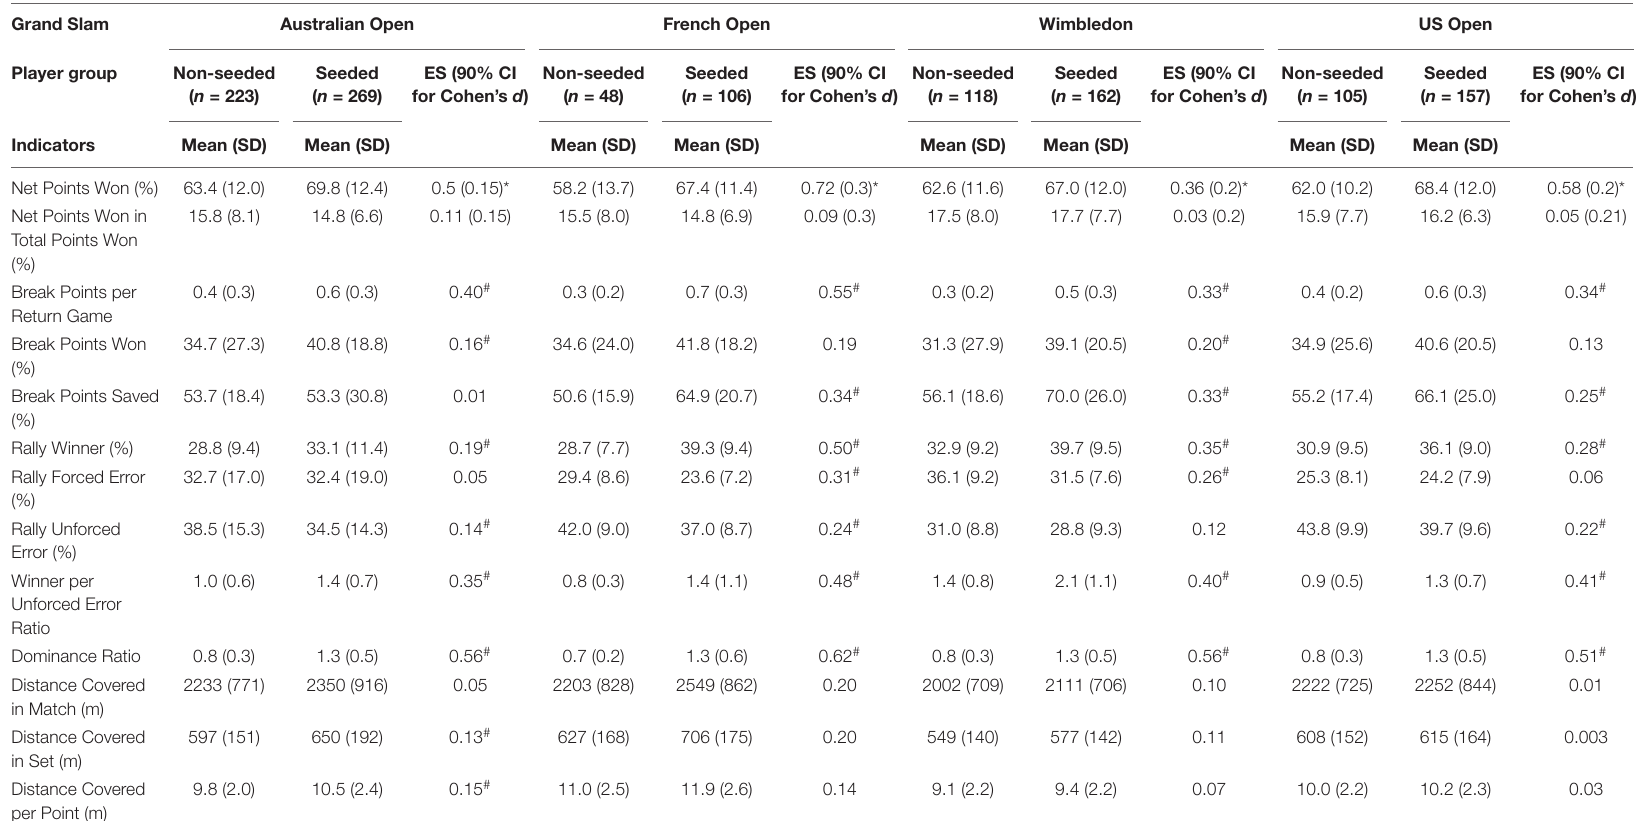
TABLE 4 | Descriptive statistics and comparisons of net point, breakpoint, efficiency, and physical performance indicators for seeded and non-seeded players during Grand Slams. Grand Slam Australian Open French Open Wimbledon